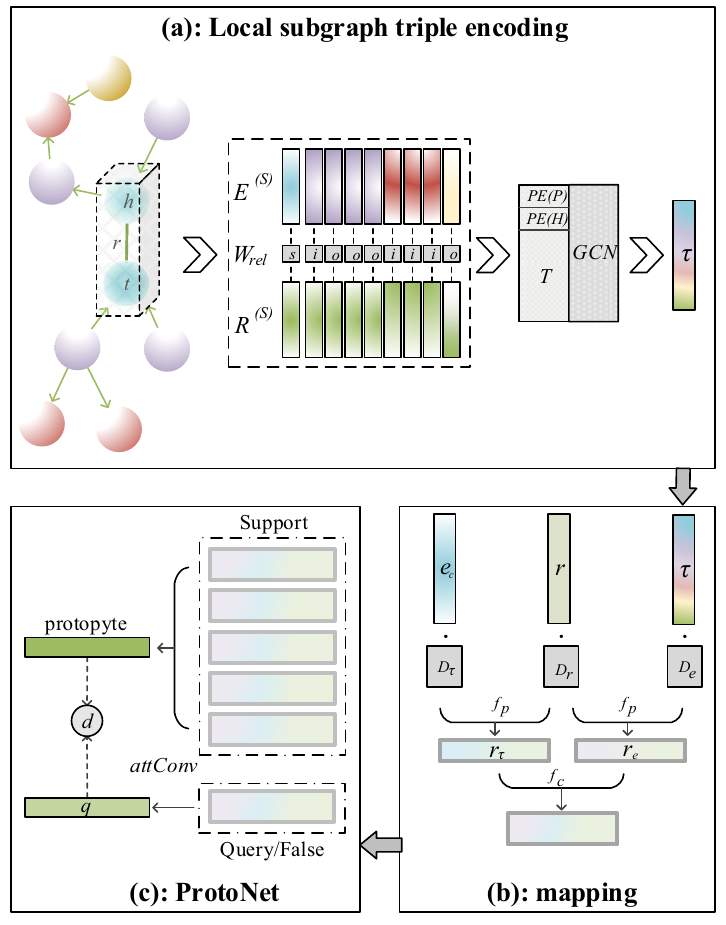
Figure 1. Overall framework of the enhanced relation representation